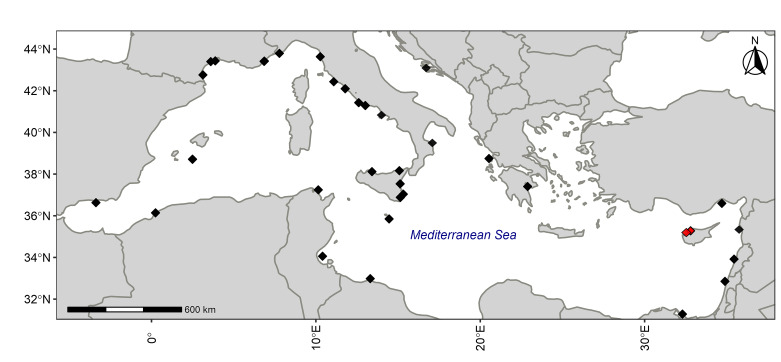
Map of known records of Pomadasys
incisus in the Mediterranean Sea. Data after: Bilecenoglu et al. 2013, Bodilis et al. 2013, Karachle et al. 2016, Ali 2018, Tiralongo et al. 2019, Bariche and Fricke 2020, Tiralongo et al. 2020. Red dots indicate the present records from Cyprus (see below).